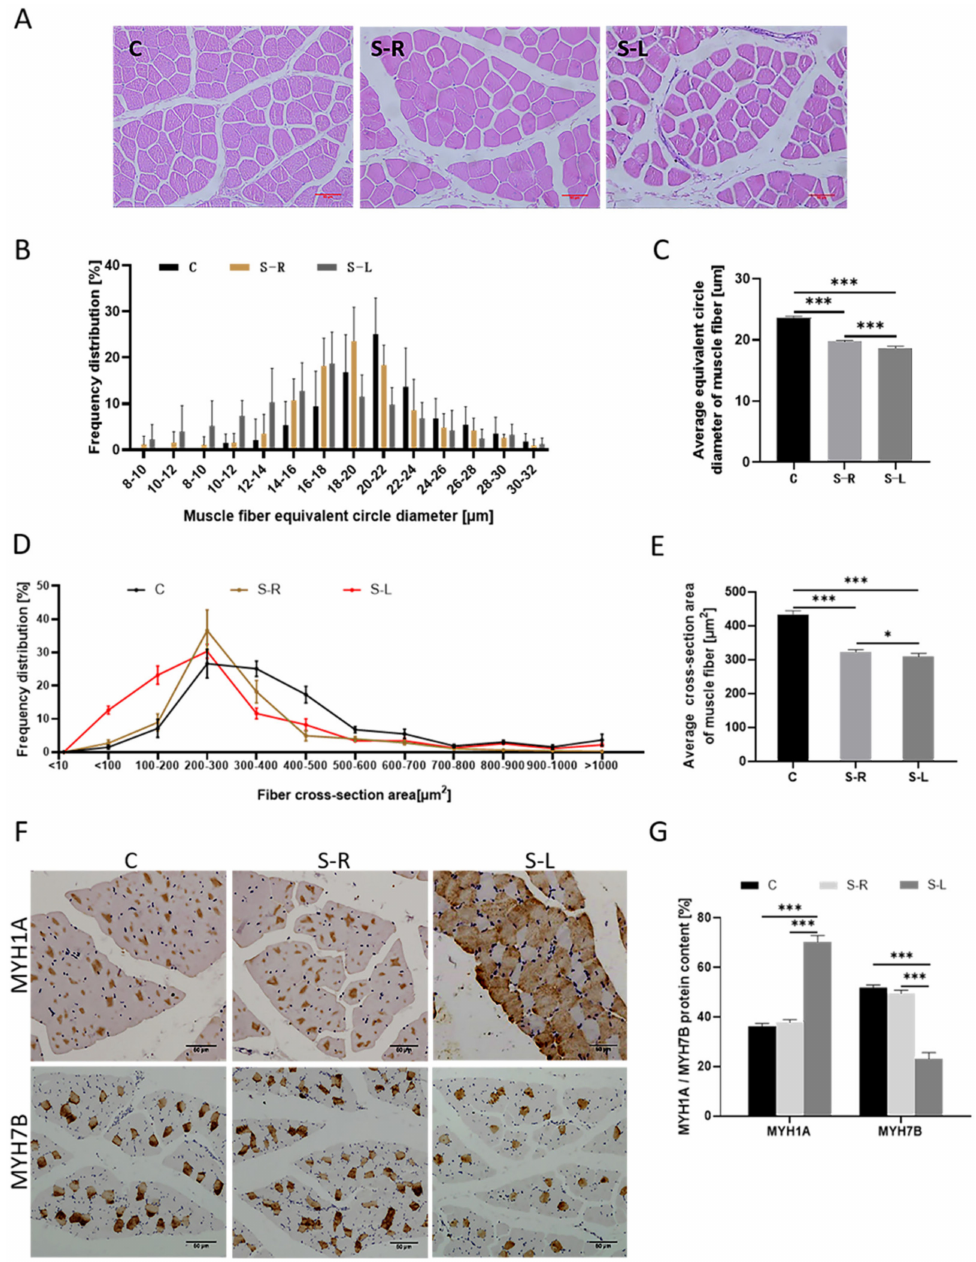
Figure 2. Atrophy model results in reduction of muscle fiber diameter and altered muscle fiber compo- sition type. ( A ) Hematoxylin and eosin (H&E) staining of gastrocnemius muscle (scale bar = 50 µ m). ( B ) Distribution of muscle fiber diameter size. ( C ) Statistics of average muscle fiber diameter size. ( D ) Distribution of cross-sectional area of muscle fiber. ( E ) Statistics of average cross-sectional area of muscle fiber. ( F ) Immunohistochemical staining for composition type of gastrocnemius muscle fiber. ( G ) Statistics of MYH1A/MYH7B protein content for composition type of gastrocnemius muscle fiber. Data are presented as mean ± SEM ( n = 3 biologically independent samples). * p < 0.05; *** p < 0.001 (Student’s t